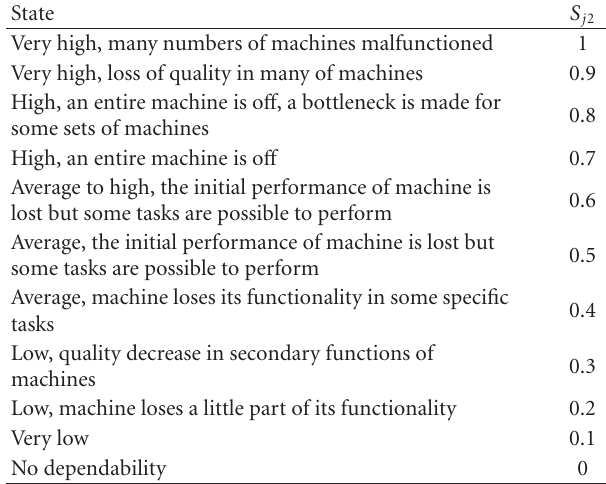
Table 5: Classification operational dependability between failure modes.